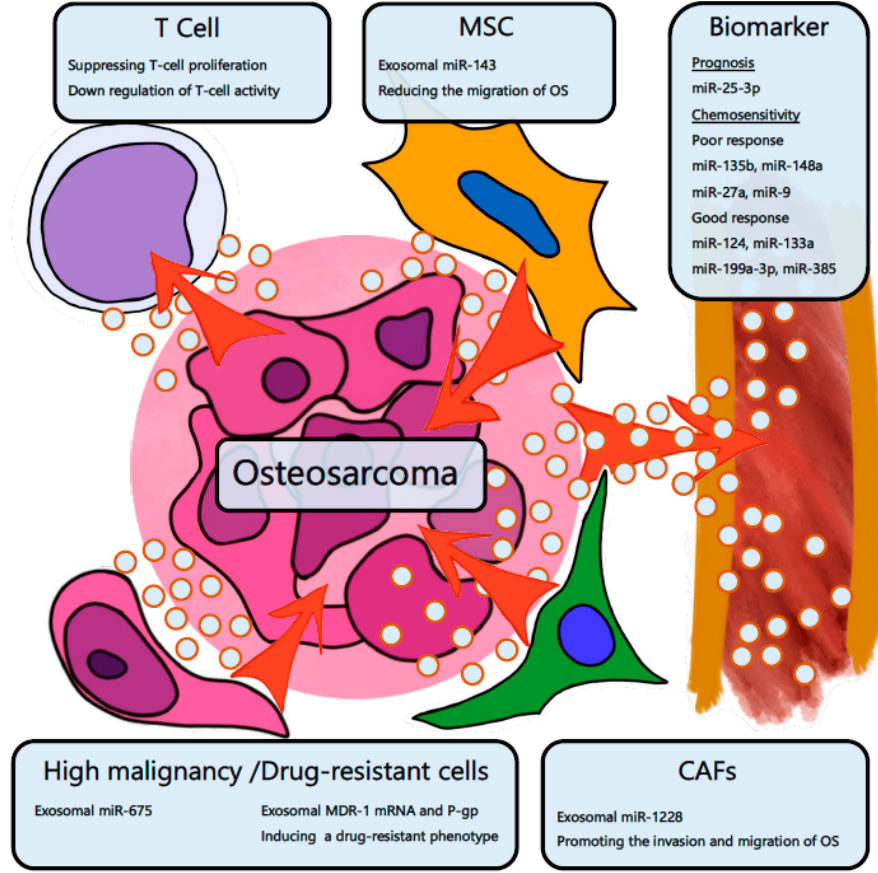
Figure 3. The exosome in the tumor microenvironment of osteosarcoma. OS cells suppress the activity of T cells by transferring exosomes. Mesenchymal stem cells (MSCs) transfer exosomal miR-143 to OS cells and suppress OS aggressiveness. High malignancy and drug-resistant cells of OS transfer exosomal miR-675, exosomal MDR-1, and P-gp mRNA and expand the malignancy. Cancer-associated stromal fibroblasts (CAFs) transfer miR-1228 to OS cells and support OS invasion. Several exosomal miRNAs can be used as biomarkers for OS prognosis and chemosensitivity. Several exosomal miRNAs have been reported as OS biomarkers (Table 2). miR-25-3p is upregulated in the exosomes derived from OS cell lines. The serum miR-25-3p increases with tumor